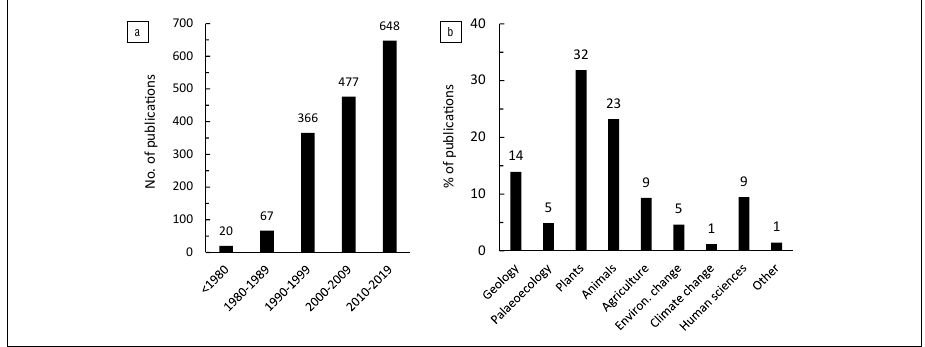
Figure 1: (a). The number of articles (N=1578) concerned with Karoo research and which Figure 1: (a) The number of articles (N=1578) concerned with Karoo research and which are listed in the Web of are listed in the Web of Science for the period 1946–2019. (b) The percentage of Science for the period 1946–2019. (b) The percentage of publications on the Karoo according to their main disciplinary publications on the Karoo according to their main disciplinary focus.